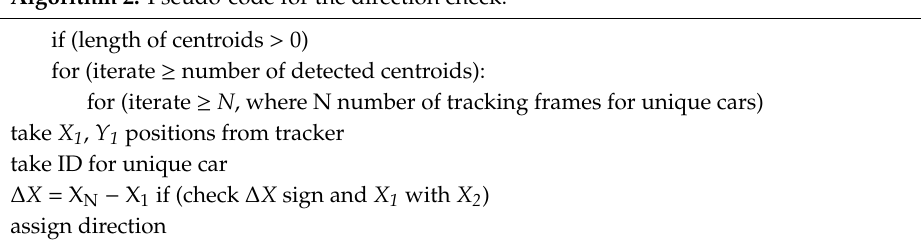
Algorithm 2. Pseudo-code for the direction